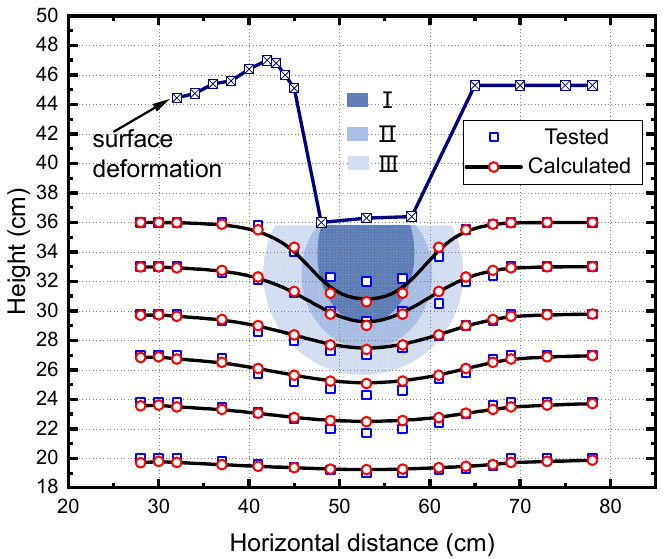
Figure 13. Comparison of the tested and calculated results for the T4 level.